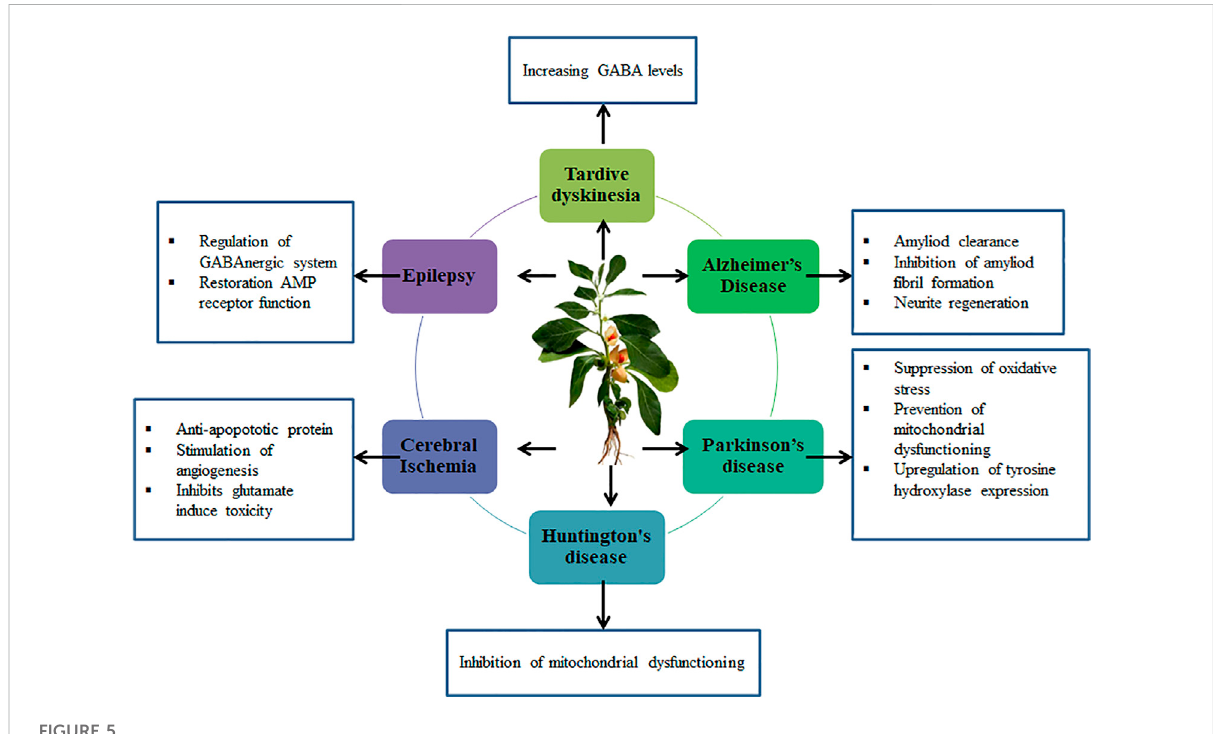
FIGURE 5 Overview of Withania somnifera on neurodegenerative